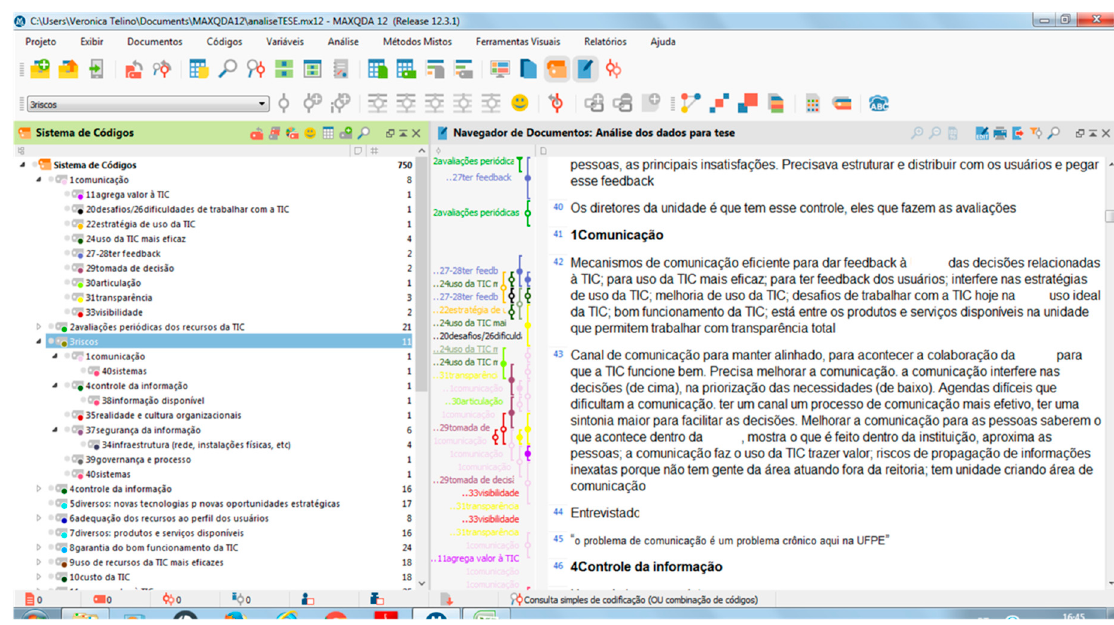
Figure 3. Coding system and compiled document produced through MAXQDA12.